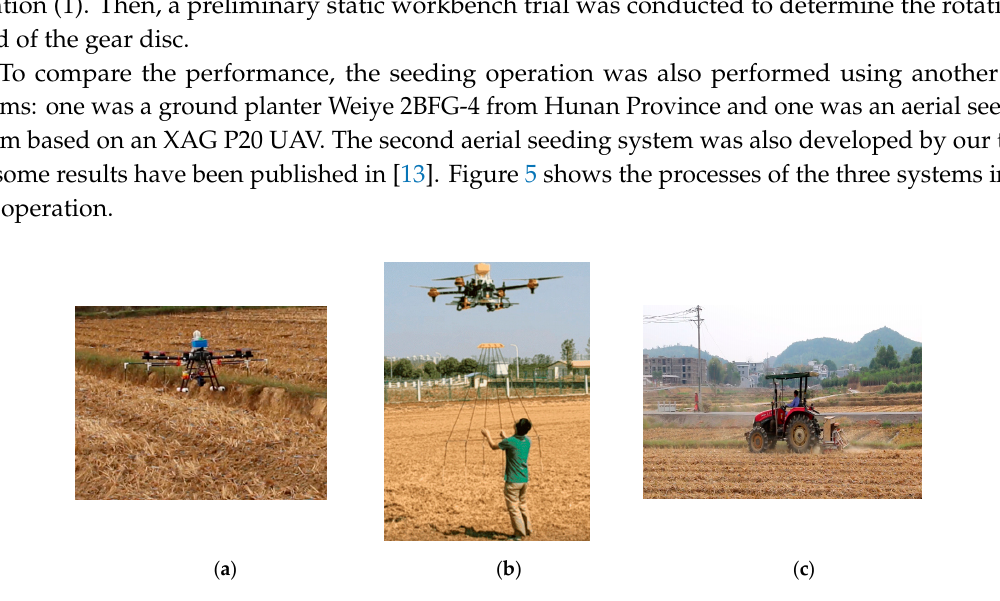
Figure 5. Field seeding experiments using three systems: ( a ) An aerial seeding system based on a Lockheed 3WDM6-10 UAV with an air-assisted centralized metering device; ( b ) An aerial seeding system based on an XAG P20 UAV with a centrifugal seed metering device and a seed guiding tube;